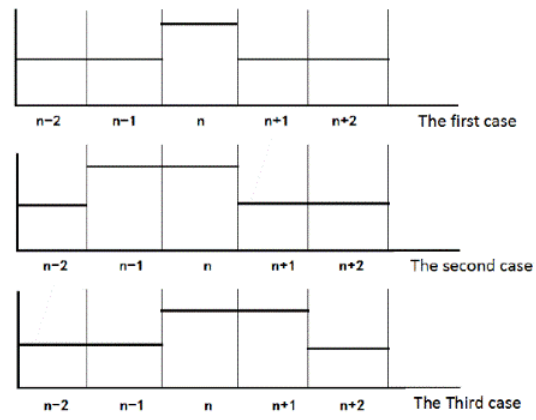
Figure 3. Change of pixels in a torrential rainstorm.